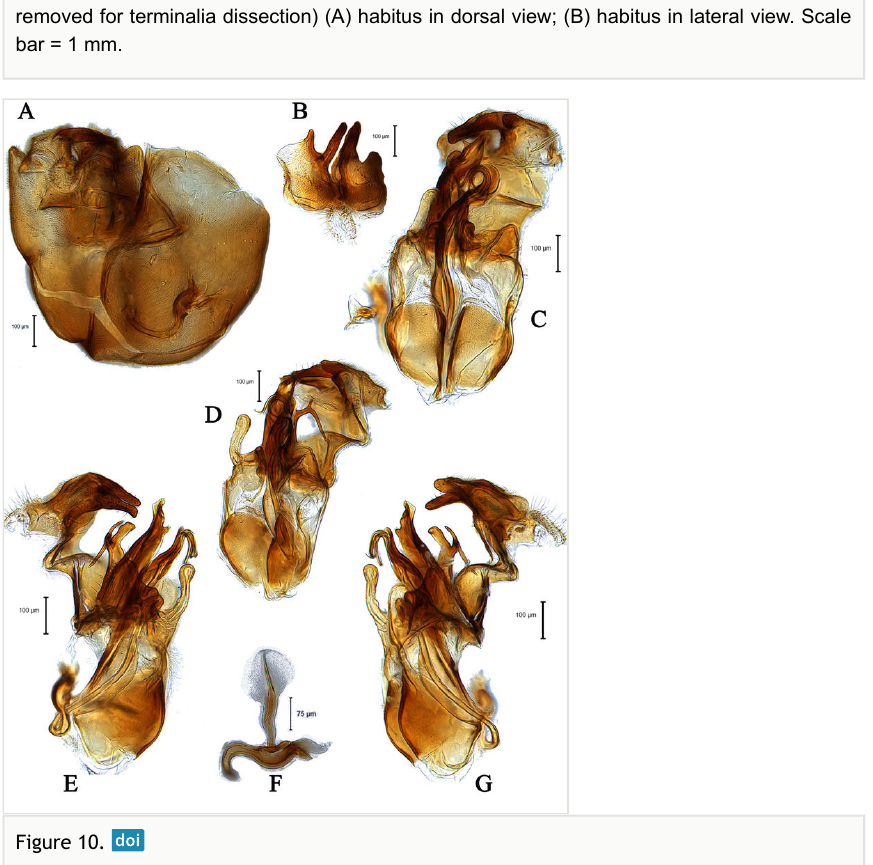
Figure 10. Male genitalia of Eudorylas corniculans Motamedinia & Skevington sp. n.(JSS52187) (A) in dorsal view; (B) surstyli in dorsal view; (C) in ventral view; (D) in lateral-ventral view; (E,G) in lateral view; (F) ejaculatory